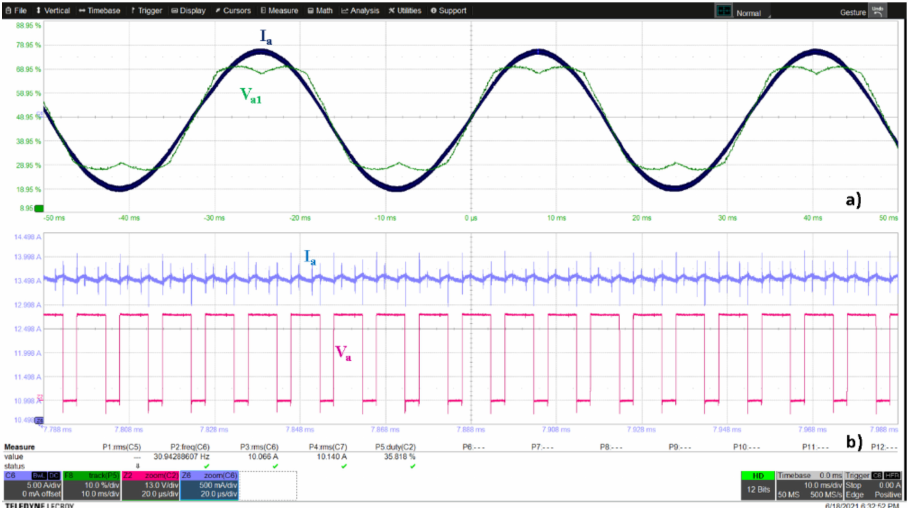
Figure 27. Experimental waveforms of output voltage and current of phase a. ( a ) Phase current and first harmonic of output inverter voltage. I a = 5 A/div, V a1 = 5 V/div, t main = 10 ms. ( b ) Voltage pulses and current ripple. ( a ) 1.24 V/div, I a = 500 mA/div, V a = 13 V/div, t zoom = 20 µ